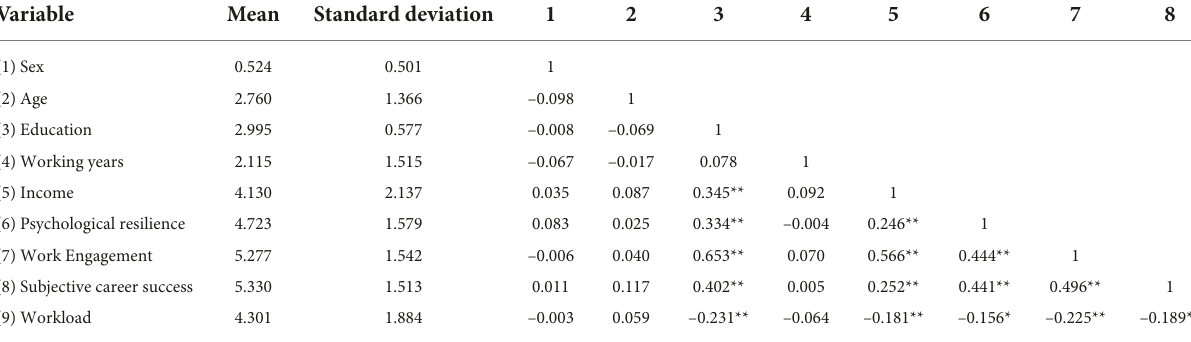
TABLE 3 Mean, standard deviation, and correlation coefficients of the study variables.